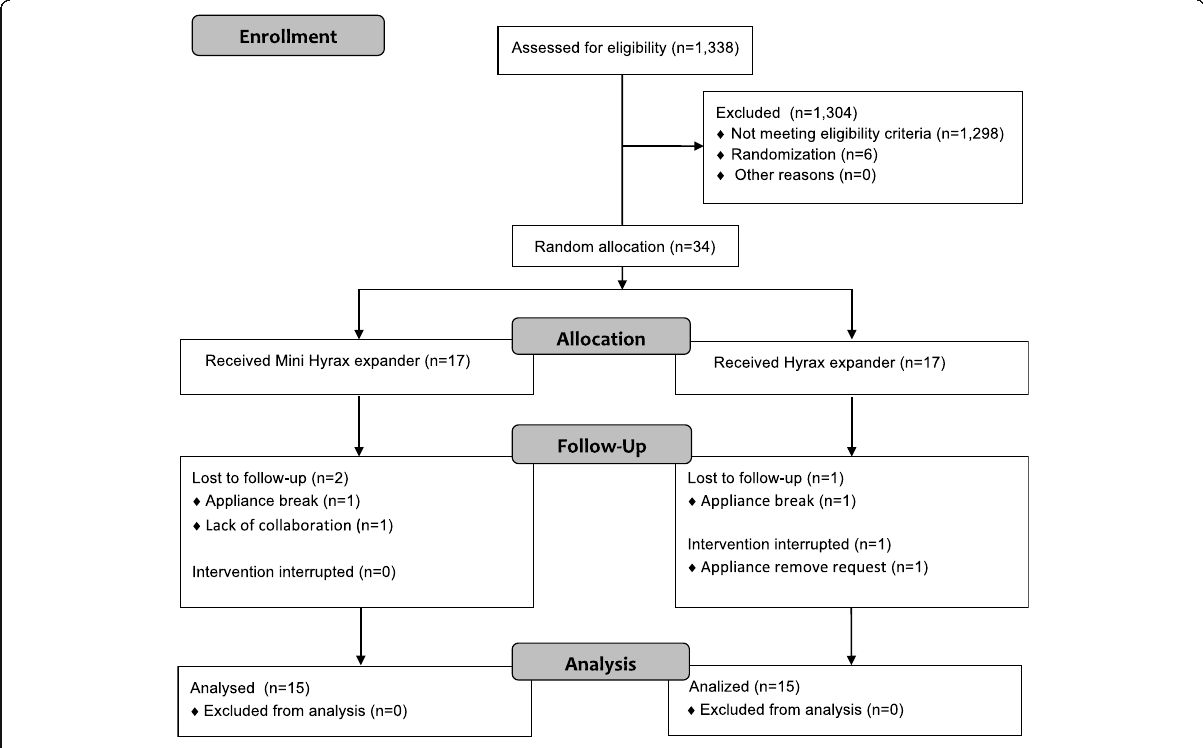
Fig. 4 CONSORT diagram showing patient flow during the